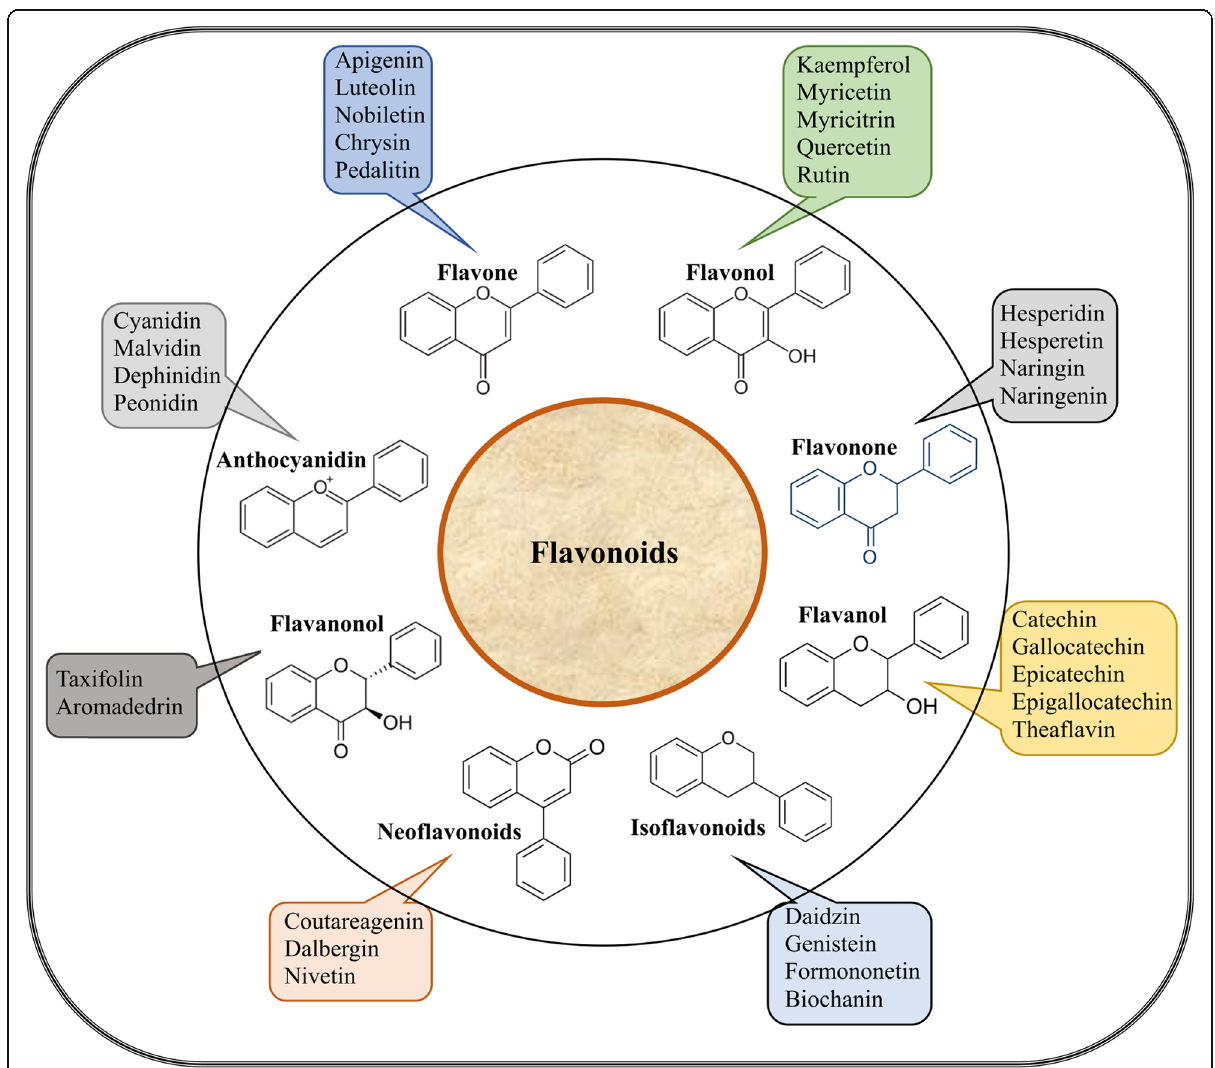
Fig. 4 Basic skeleton of flavonoids and its